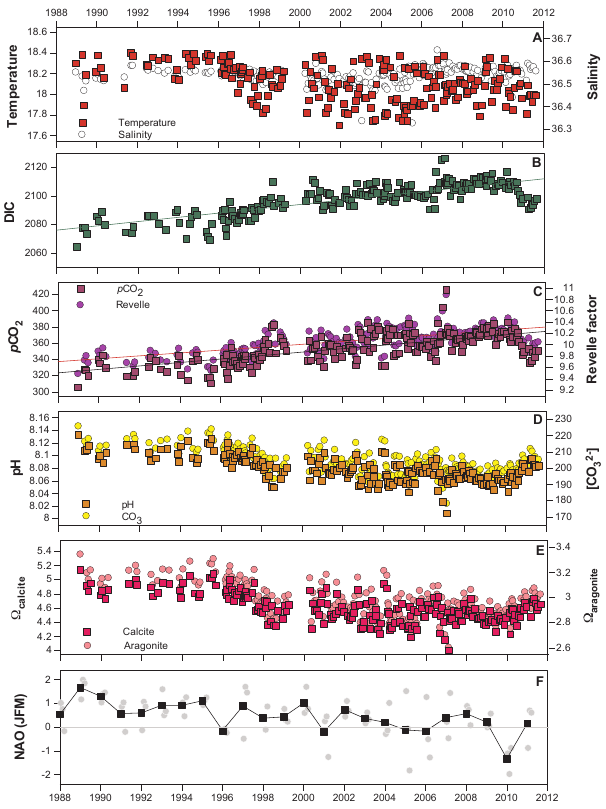
Fig. 2. Long-term observations and trends of STMW hydrogra- phy, seawater carbonate chemistry and ocean acidification indica- tors from 1988 to 2011 at the BATS (Bermuda Atlantic Time-series Study; 31 ◦ 40 0 N, 64 ◦ 10 0 W) site located near Bermuda in the NW Atlantic Ocean. Slopes and statistics of regressions are listed in Ta- ble 1. (A) Sea surface temperature ( ◦ C; black symbol) and salin- ity (red symbol). (B) Surface dissolved inorganic carbon (DIC, µmolkg − 1 , green symbol). (C) Seawater p CO 2 (µatm; purple sym- bol) and Revelle factor ( β) (fuchsia symbol). (D) Surface seawa- ter pH (orange symbol) and [CO 2 − ] (µmolkg − 1 , yellow symbol). 3 (E) Surface saturation state of calcite ( (cid:127) calcite ) (pink symbol) and aragonite ( (cid:127) aragonite ) (light pink symbol). (F) time-series of Jan- uary, February and March NAO index (grey circles) and mean win- ter NAO (JFM; black square symbols and line).